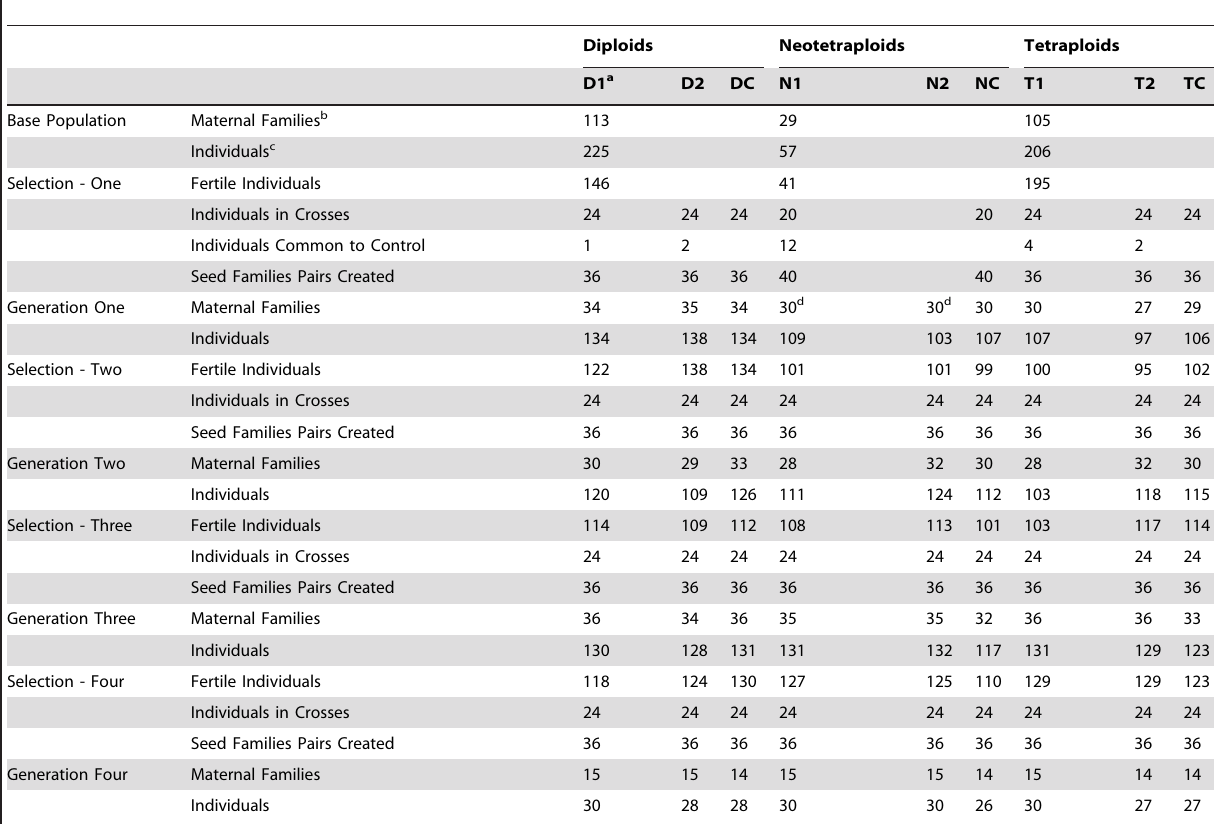
Table 1. Number of individuals involved in each stage of the experiment by line.